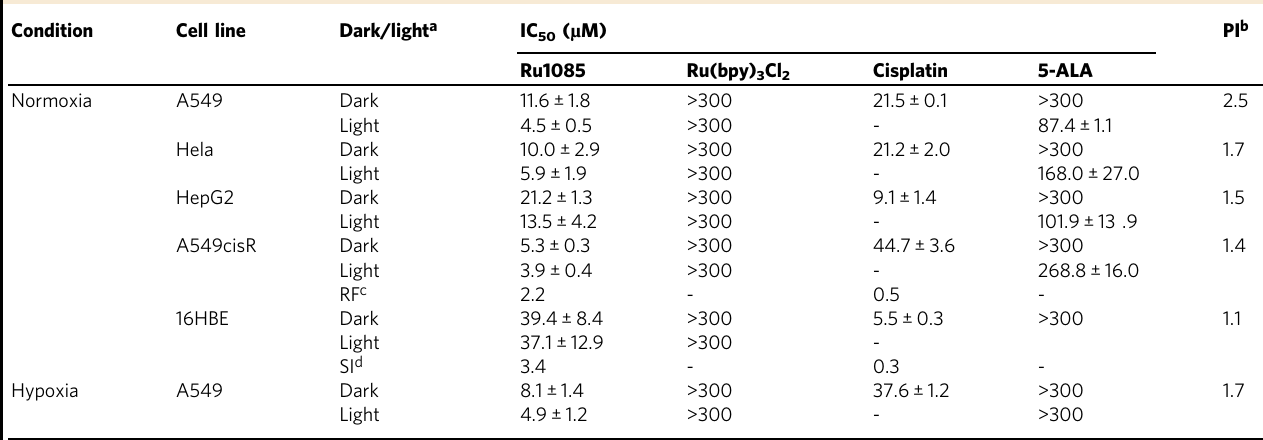
Table 1 IC 50 value of Ru1085, Ru(bpy) 3 Cl 2 , cisplatin and 5-ALA against various cell lines by MTT assay.